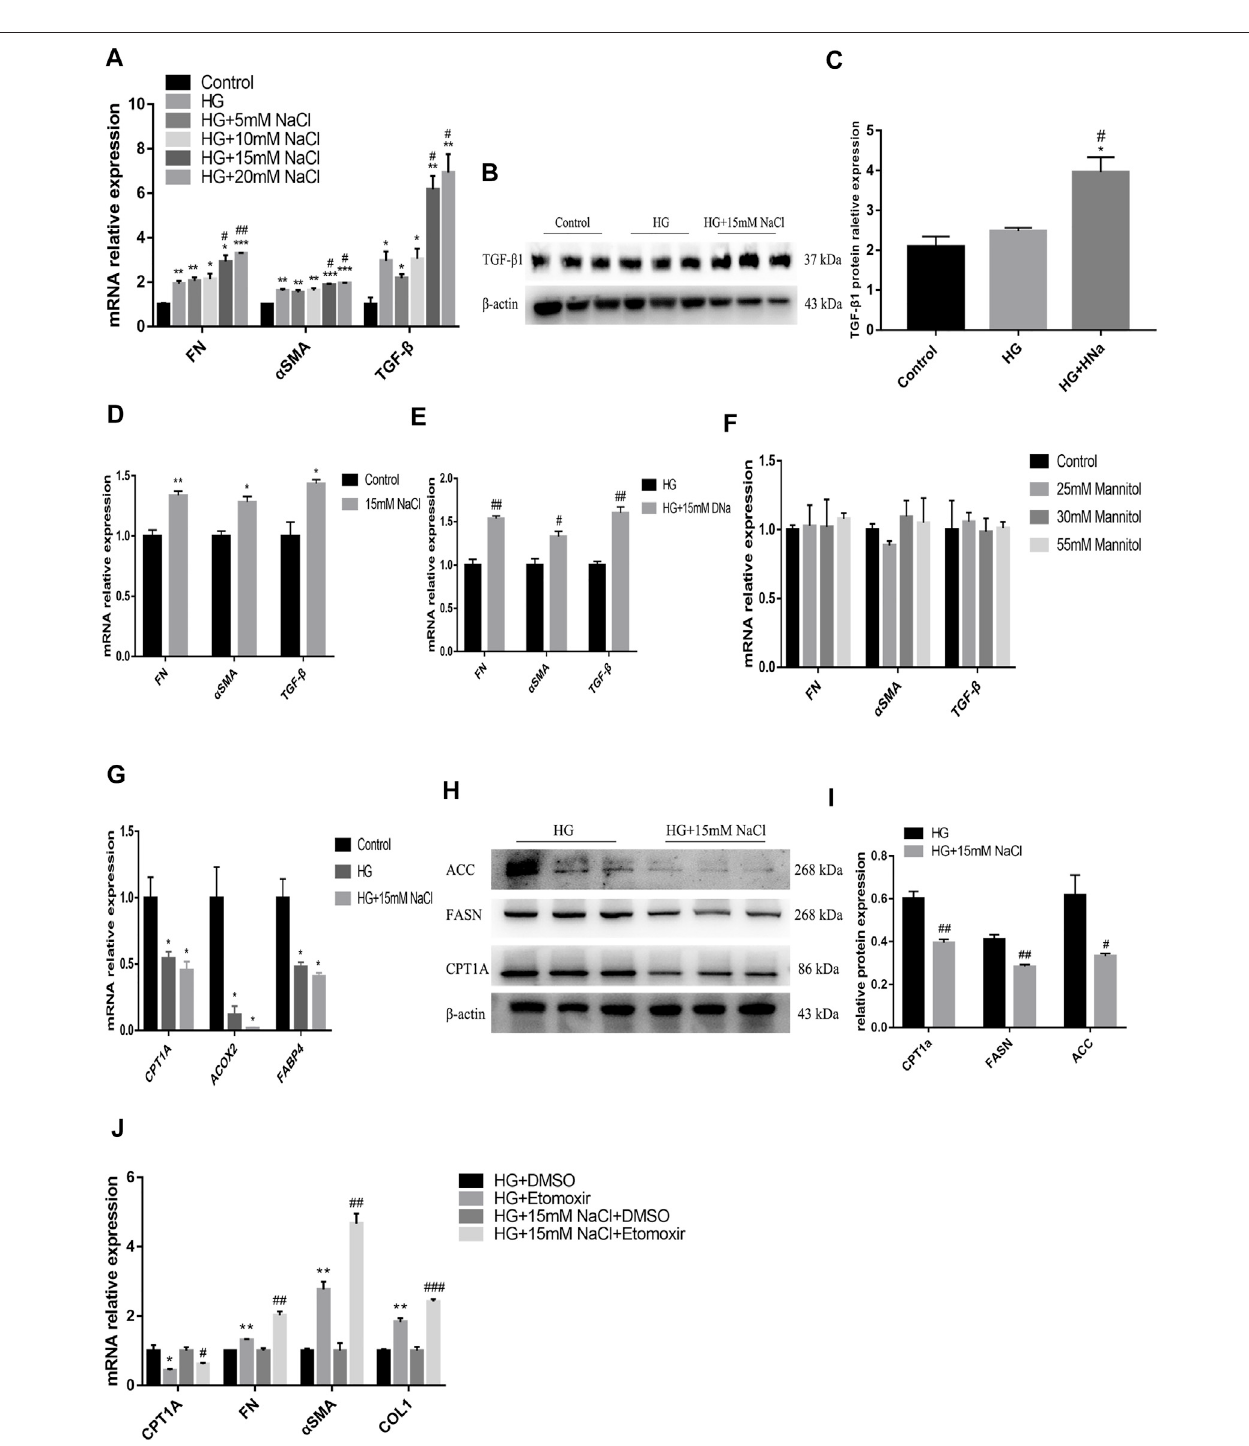
FIGURE 4 | High salt suppresses fatty acid metabolism pathway to aggravate the damage of HG-treated HK-2. Expression of fi brosis-related genes (A) and proteins (B,C) in HK-2 after exposure to HG and different concentrations of NaCl. Expression of fi brosis-related genes in HK-2 respectively cultured with 15 mM NaCl (D) , sodium gluconate (E) , 25, 30 and 55 mM mannitol (F) . Expression of fatty acid metabolism-related genes (G) and proteins (H,I) in HK-2 with HG and 15 mM NaCl cultured.* p < 0.05,** p < 0.01and*** p < 0.001vs.Controlgroup;# p < 0.05and## p < 0.01vs.HGgroup. (J) ExpressionofCPT1Aand fi brosis-relatedgeneswere detectedinHK-2treatedwithEtomoxir.* p < 0.05and** p < 0.01vs.DM+DMSOgroup;# p < 0.05,## p < 0.01and### p < 0.001vs.HG+NaCl+DMSOgroup.Alldata are mean ± SEM, n (cid:1) 3 per group.